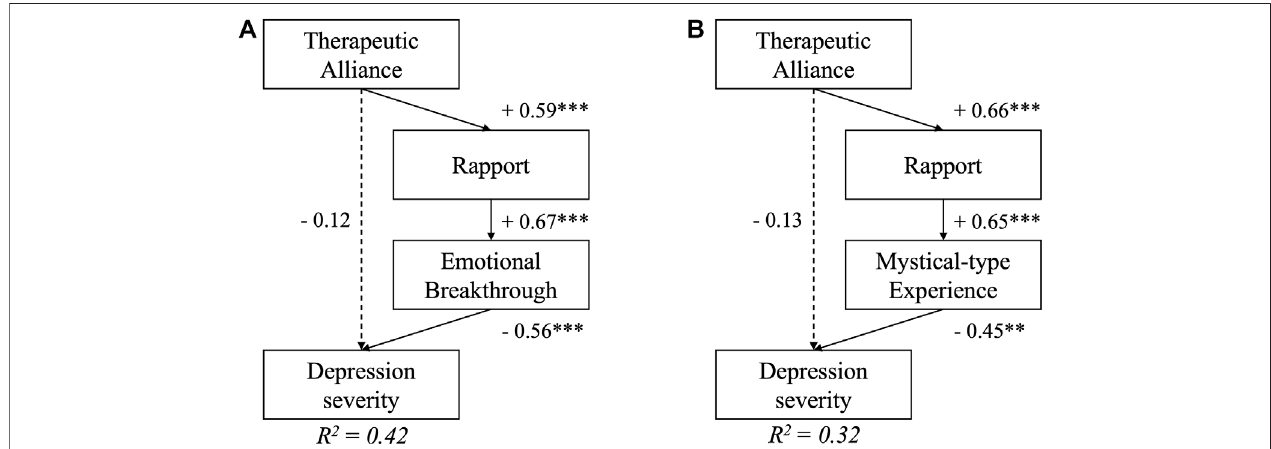
FIGURE 3 | Path models testing the primary hypothesis that therapeutic alliance would lead to better depression scores 6 weeks following psychedelic-assisted psychotherapy. Serial mediationoftherapeutic allianceviapre-sessionrapport and A)Emotional Breakthrough andB) Mystical-type experienceswere supported bythe models. Depression severity at the6-weeksEndpointwasadjusted forbaselinedepression scores( p > 0.1, not displayed in the fi gure),whichby itselfaccountsfor R 2 = 0.12, i.e., 12% of variance in the fi nal outcome. Numbers represent standardised regression coef fi cients for signi fi cant (solid) and non-signi fi cant (dashed) paths. **indicates p < 0.01, *** p < 0.001.